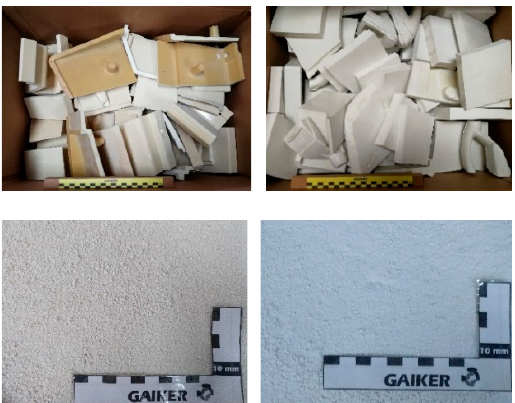
Figure 1. RPUF B: medium-/high-density (650–750 g/m 3 ) ochre-colored expanded rigid PU pieces (above level) and milled (below level), RPUF C: high-density expanded rigid PU parts, bi-density solid surface type (850 g/m 3 ), white color with micronized alumina and titanium oxide fillers (above right) and milled (below right).